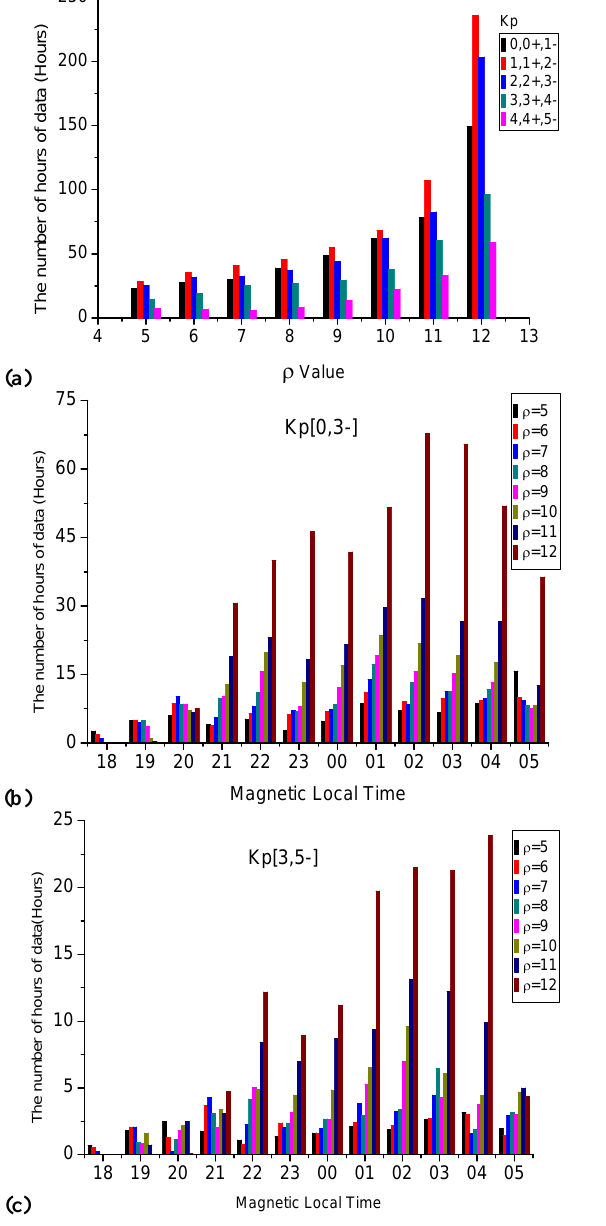
Figure 1. (a) The number of hours of data in each ρ bin for five different Kp bins. (b) The number of hours of data in each magnetic local time bin for eight different ρ bins at magnetic quiet time Kp[0,3-]. (c) The number of hours of data in each magnetic local time bin for eight different ρ bins at magnetic moderate activity time Kp[3,5-].